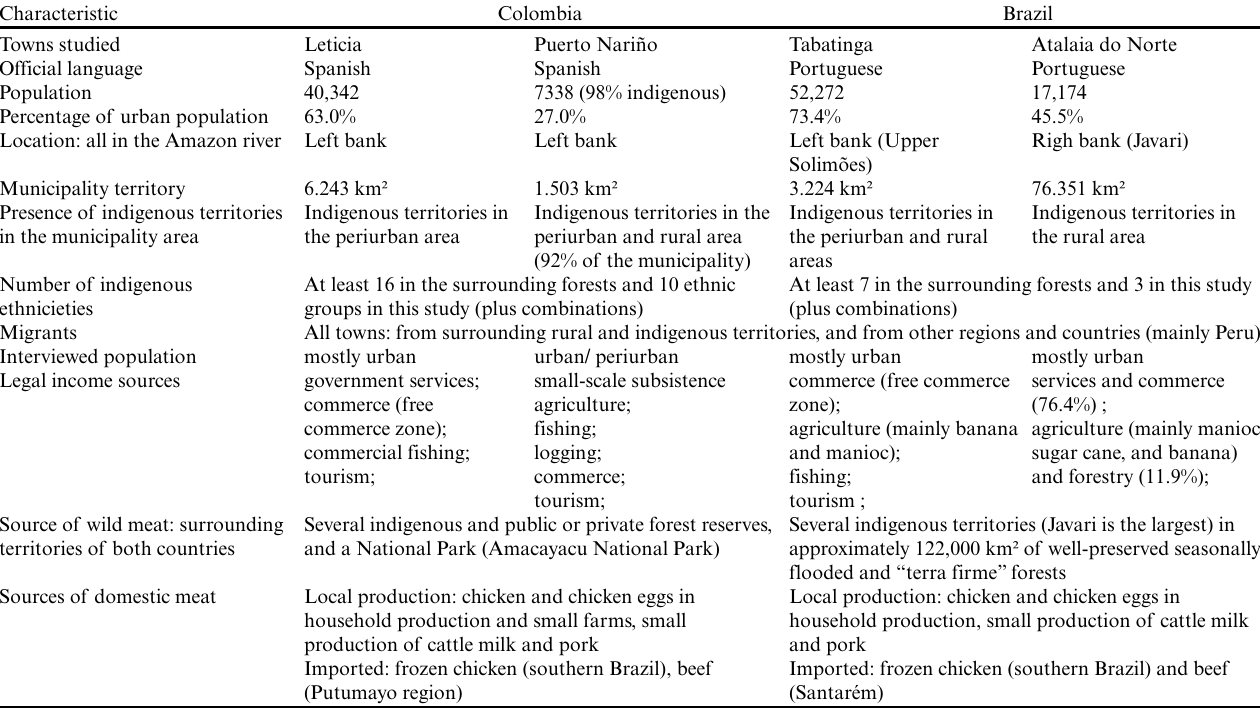
Table 1 . Characteristics of the studied